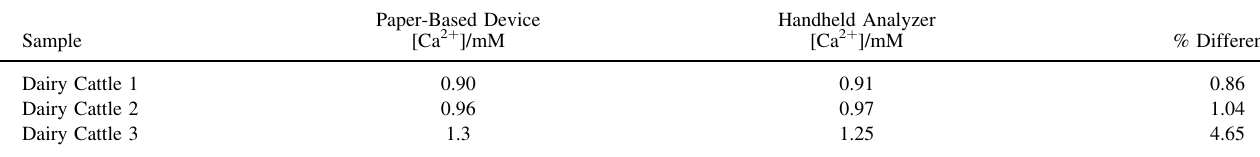
Table III. Real sample analysis of dairy cattle blood with a paper-based device and a commercially available analyzer. Paper-Based